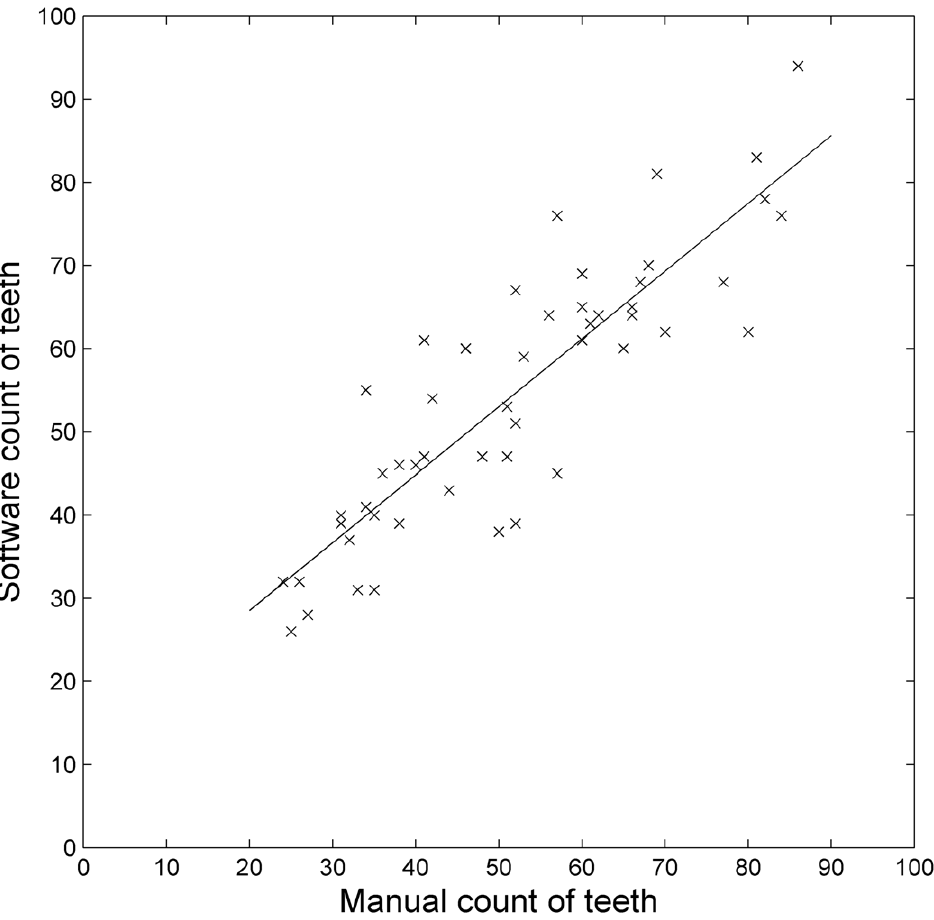
Figure 5. Comparison of manual count of teeth on each leaf with the system’s estimate. Each cross represents one of 50 leaves. The line is a least-squares best-fit line.